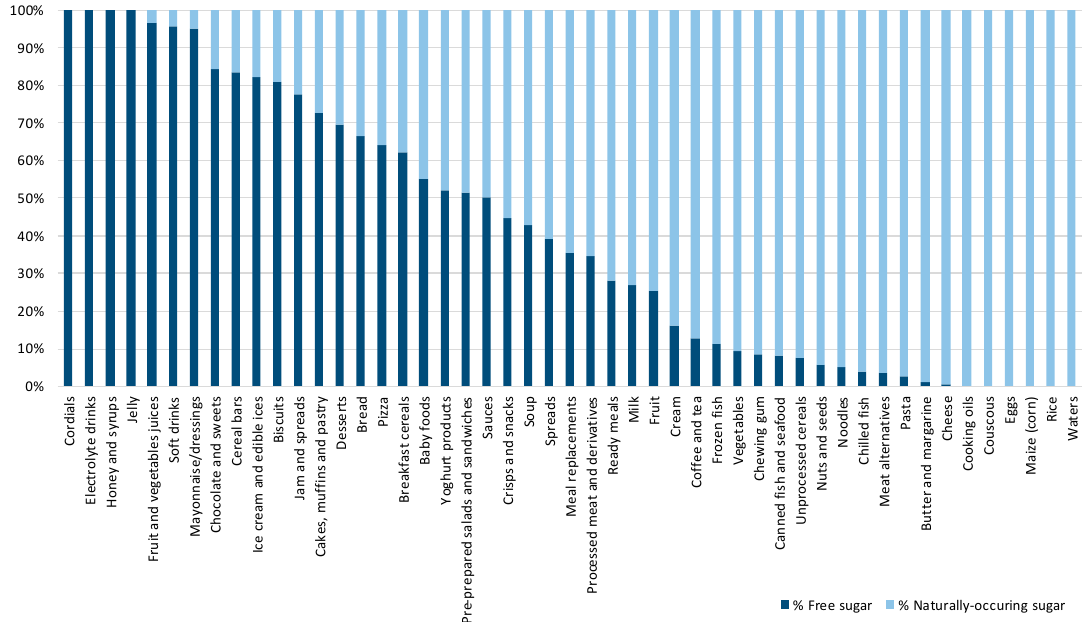
Figure 3. The amount of free sugar as a proportion of total sugar (%) per food category.